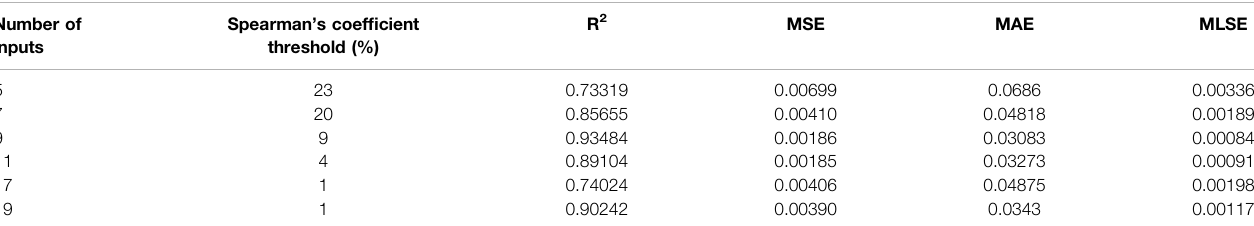
TABLE 9 | ML model accuracy corresponding to number of input